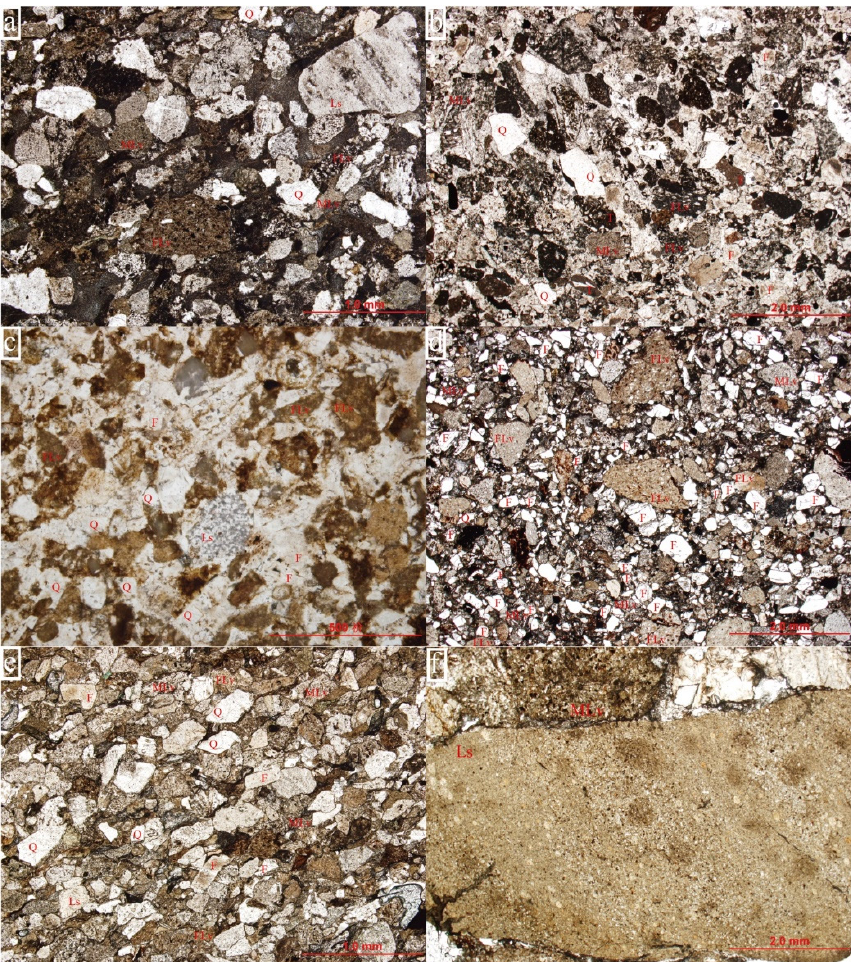
Figure 4. Representative photomicrographs of textures and minerals of the lithic clasts and detrital grains under plane-polarized light. The sandstone from the ( a ) Jiamuhe Formation (Sample ID: G15-04, sandstone clastic component: Q16%, F10%, L74%), ( b ) Fengcheng Formation (Sample ID: B25-01, Q11%, F22%, L67%), ( c ) Xiazijie Formation (Sample ID: 817-01, Q22%, F28%, L50%), ( d ) Lower Wuerhe Formation (Sample ID: MH012-2, Q6%, F29%, L65%) and ( e ) Upper Wuerhe Formation (Sample ID: JT1-2, Q9%, F21%, L70%). ( f ) The conglomerate with the pebbles of sedimentary and volcanic rocks from the Lower Wuerhe Formation (Sample ID: C73). Abbreviations of minerals: F, feldspar; FLv, felsic volcanic clasts; Ls, sedimentary lithic fragment; MLv, mafic volcanic clasts; Q, quartz; T, tuff.